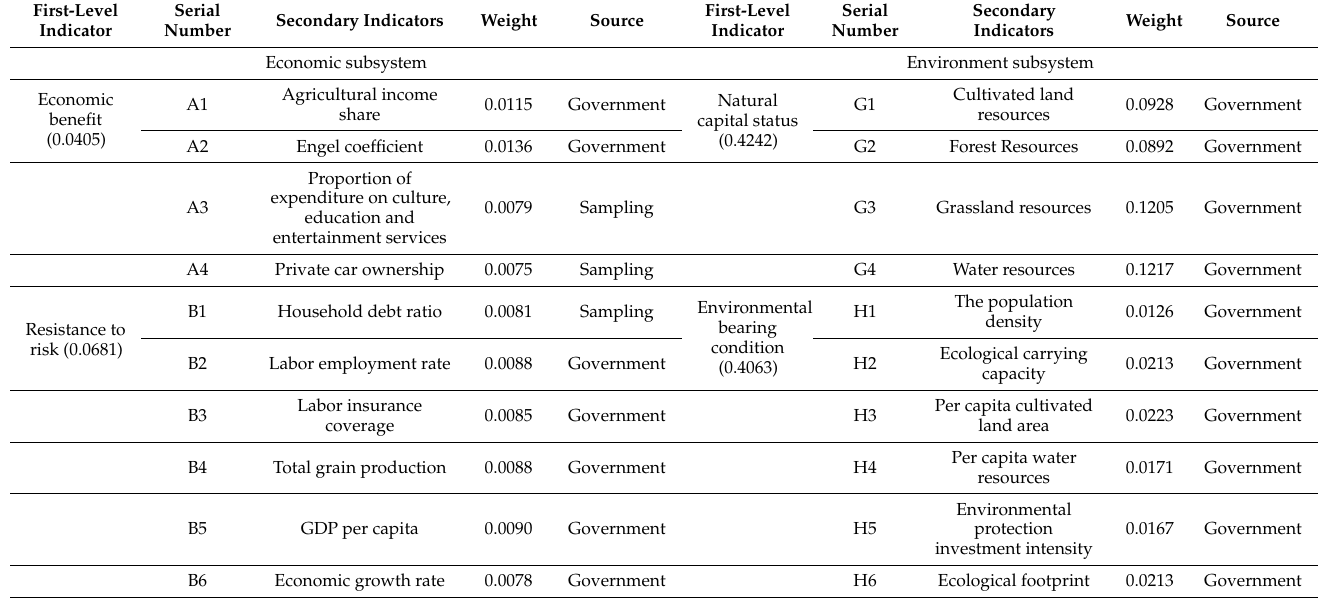
Table 3. Evaluation system for sustainable livelihood of farmers in ecological resettlement area in the upper reaches of the Yellow